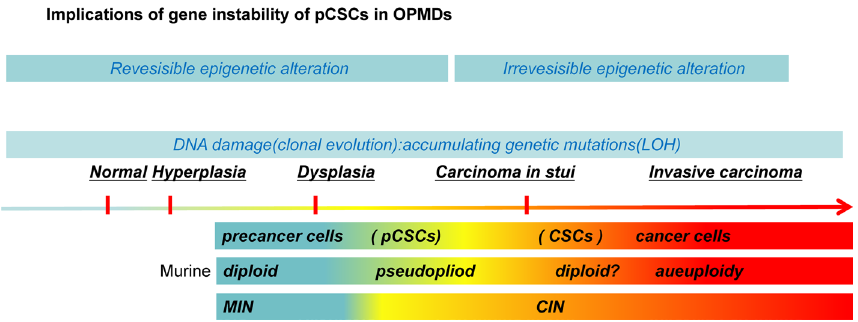
Fig. 2 In precancerous stem cells (pCSCs), a qualitative mutation of oncogenes or tumor suppressor genes may result in the loss of the benign differentiation and commitment capability of cancer stem cells (CSCs). Murine pCSC clones are pseudodiploid, whereas CSC clones are usually diploid. The number of chromosomal translocations in CSCs does not increase compared with that in pCSCs. Cells with microsatellite instability (MIN) are normally approximately diploid. The core concept of the above hypothesis has been described elsewhere [26]. LOH loss of heterozygosity, CIN chromosomal